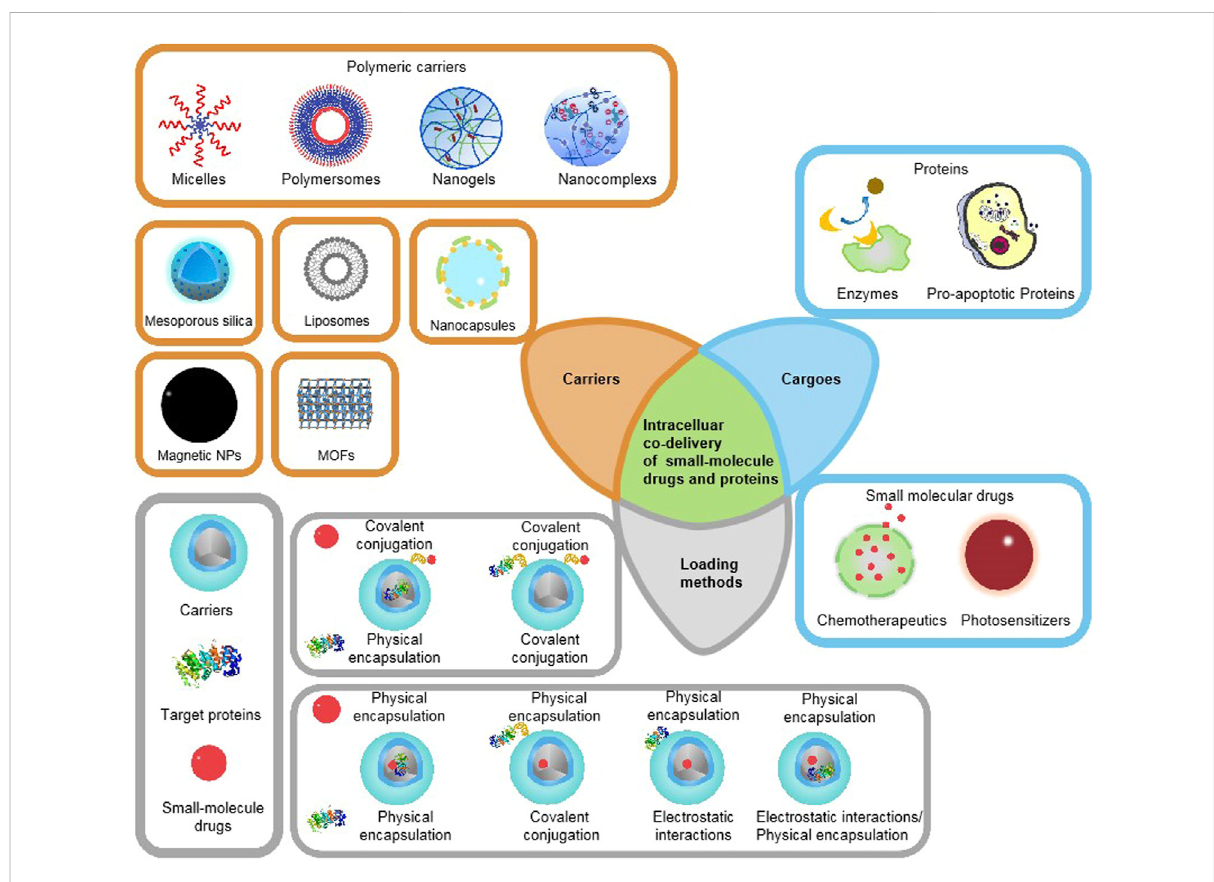
FIGURE 1 Schematic illustration of existing therapeutic proteins, small-molecule drugs, major categories of co-delivery systems, and commonly used loading/encapsulation strategies, as discussed in this Review.